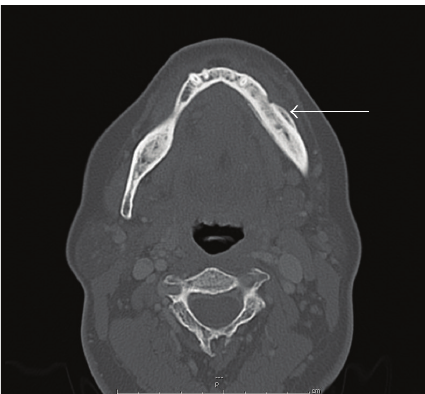
Figure 1: CT scan of the mandible. The CT scan demonstrates thickening of the mandibular body (arrow) with adjacent tissue stranding. This was thought to represent metastatic disease.